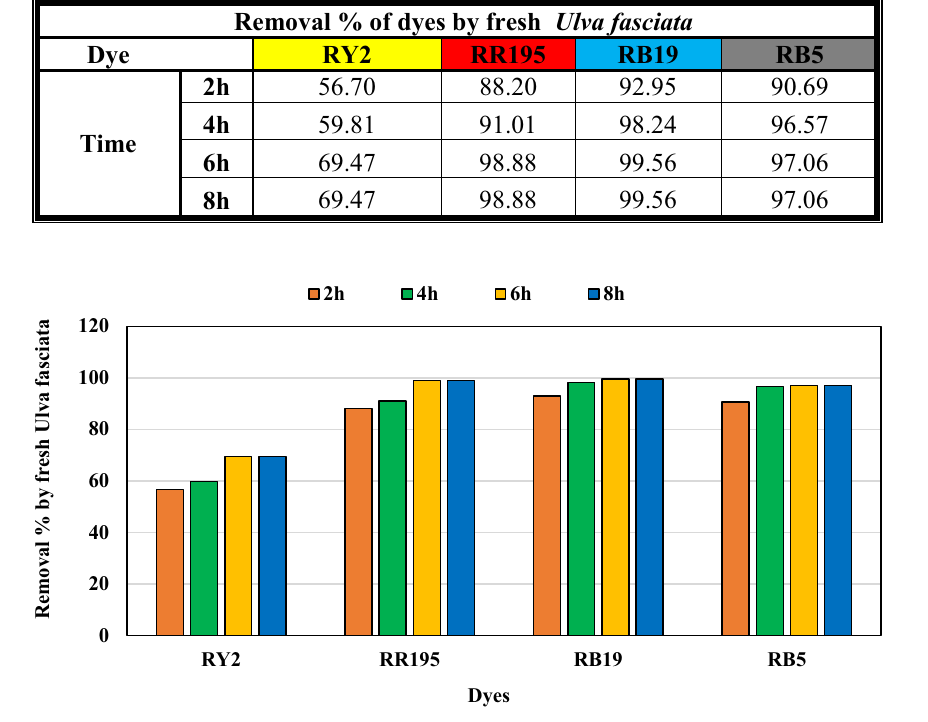
Fig. 13 Effect of contact time (at optimized conditions) on the removal percentages of the four studied dyes by fresh Ulva